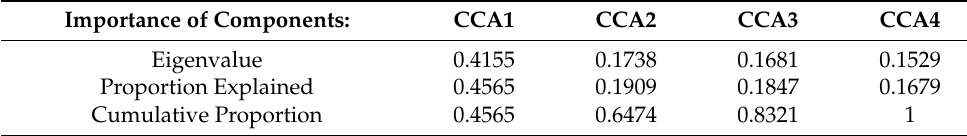
Table 3. Accumulated constrained eigenvalues.